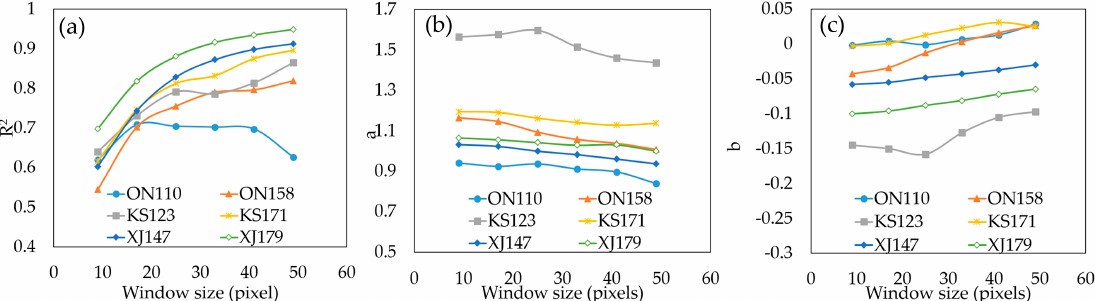
Figure 8. The variations of: R 2 ( a ); a ( b ); and b ( c ) with the increasing window size for fine- and coarse-resolution NDVI pairs over different study sites.